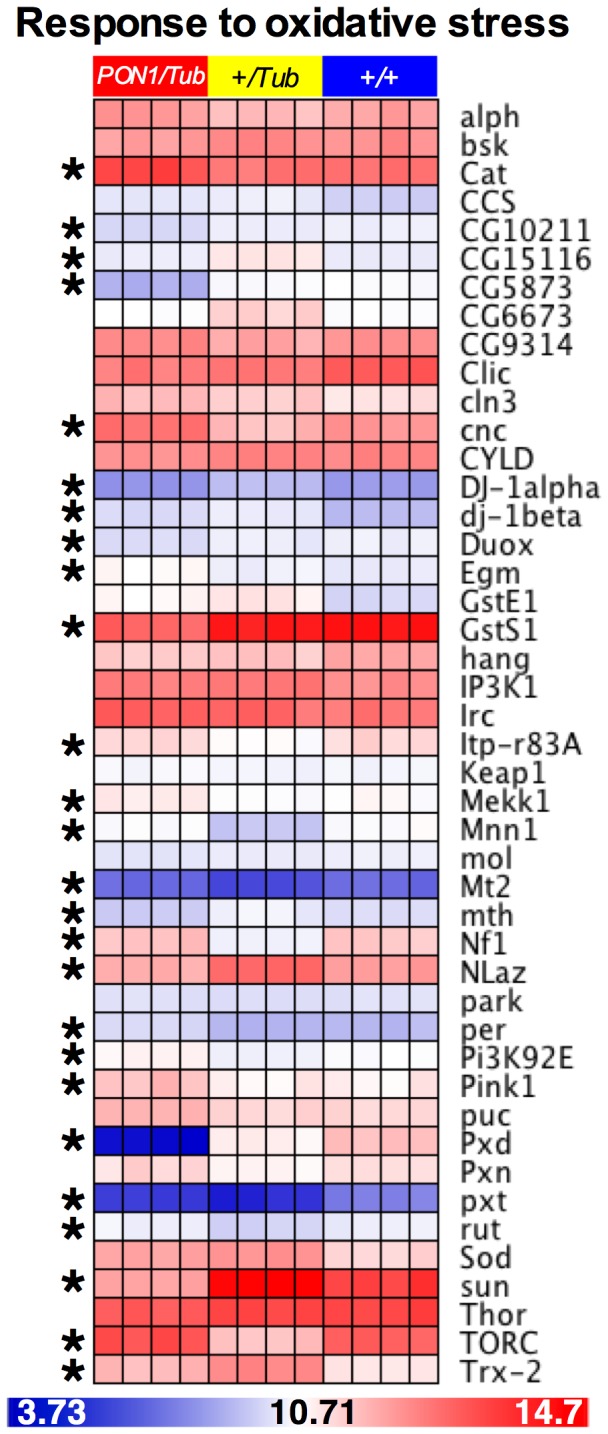
Expression of human PON1 alters expression of oxidative stress genes in D. melanogaster.Heatmap of expression values of genes in the Gene Ontology term “Response to oxidative stress” in PON1/Tub, +/Tub and +/+ D. melanogaster. Columns represent samples and rows correspond to genes. Color scale corresponds to RMA expression value. * = genes differentially expressed between +/Tub and PON1/Tub (FDR<0.01). n = 4 aliquots of 20 flies per genotype.